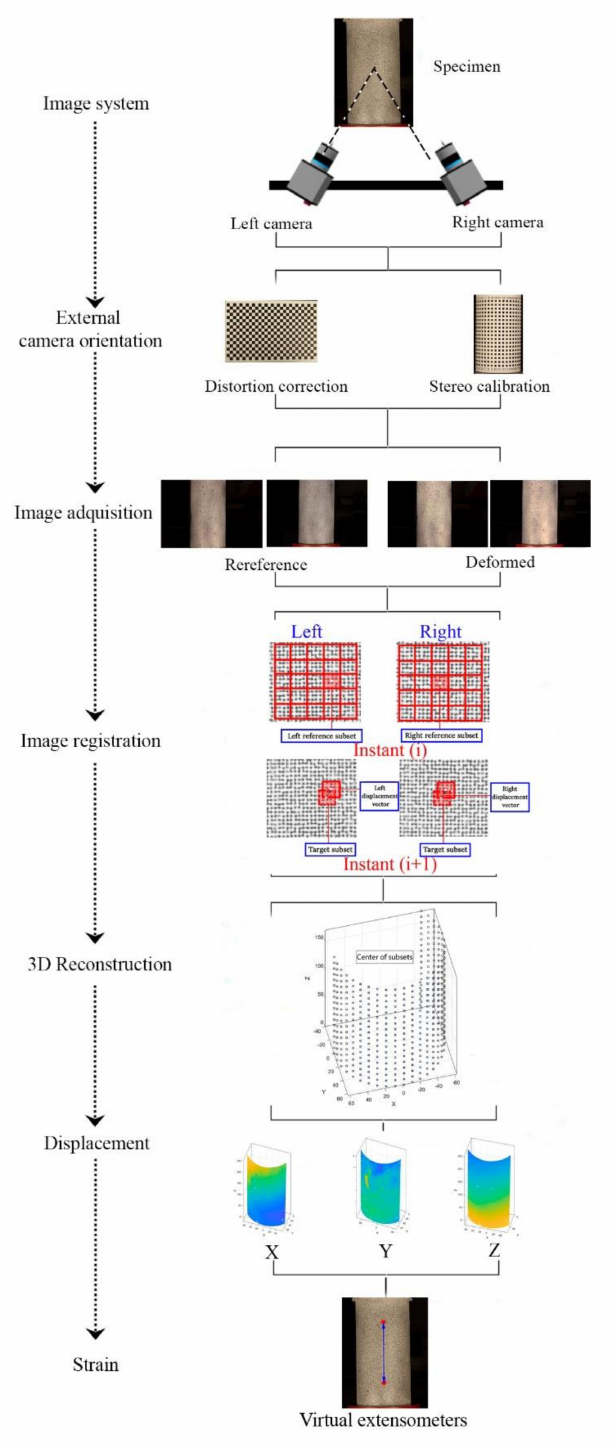
Figure 4. Graphical representation of the 3D-DIC